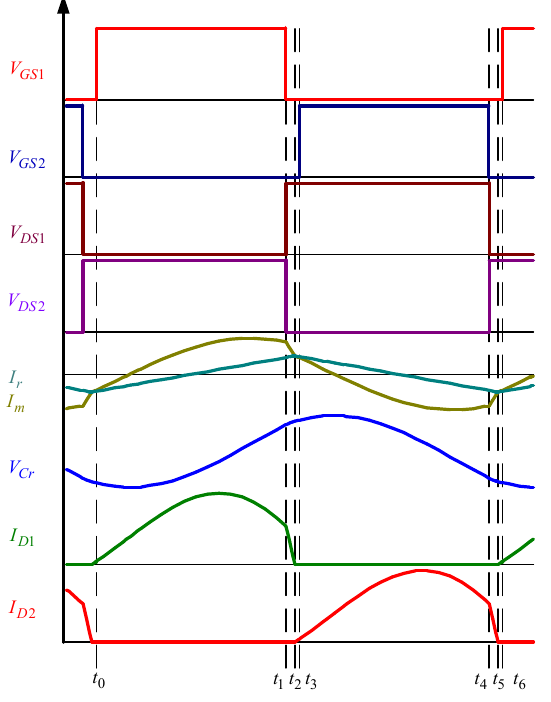
Figure 6. Schematic diagram of LLC resonant converter operated in Region 1 (zero voltage switching,